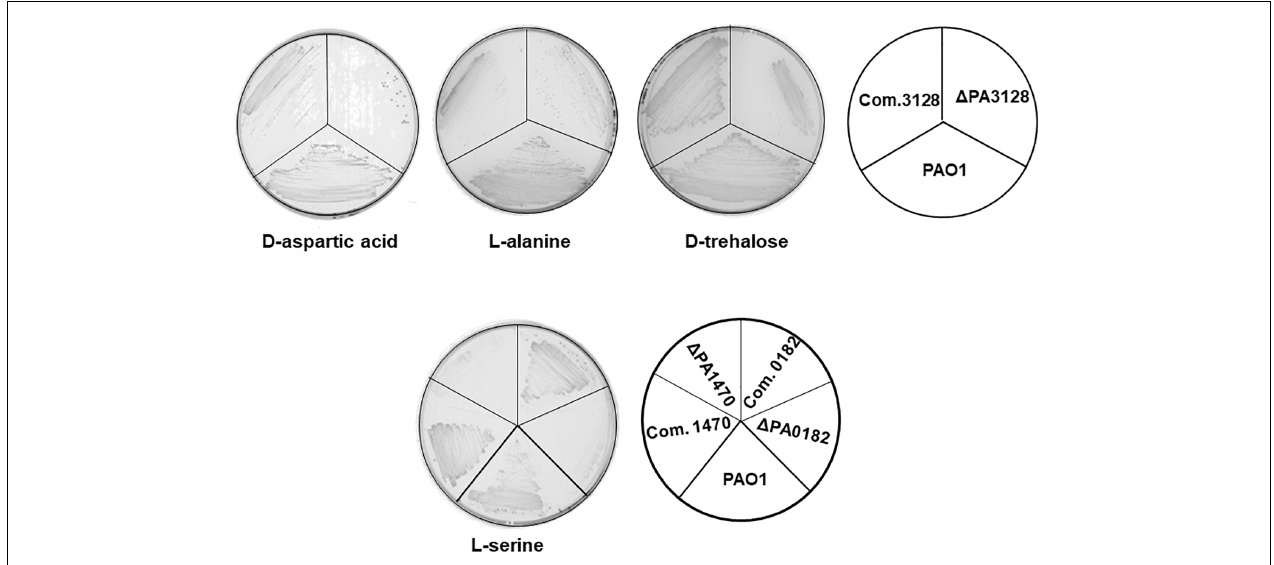
FIGURE 4 | Growth of P. aeruginosa strains on ME medium supplemented with specific chemical compounds as the carbon source. Chemical compounds included D -aspartic acid, L -alanine, L -serine, and D -trehalose at final concentrations of 100 mmol/L. PAO1, P. aeruginosa wild-type strain; (cid:49) PAxxxx, P. aeruginosa OAR mutant strain. Com.xxxx, (cid:49) PAxxxx strain carrying a plasmid-encoded PAxxxx gene.